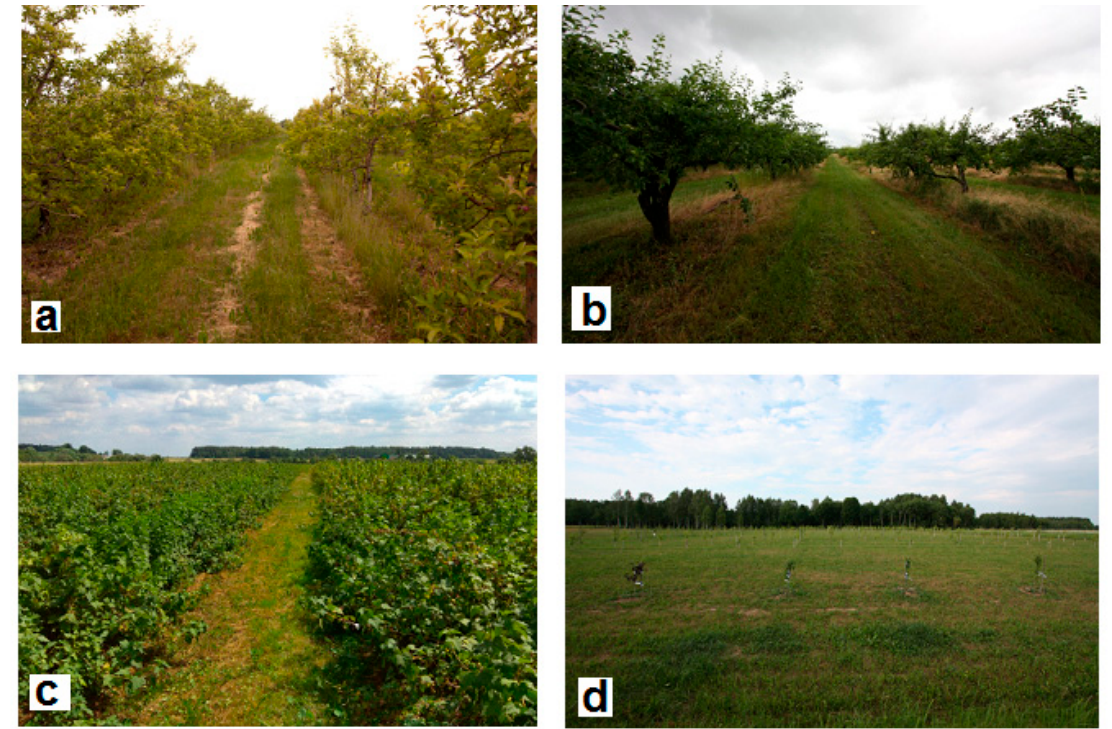
Figure A2 . Research sites with medium farming intensity: ( a ) apple fruit farm at site 1; ( b ) apple fruit farm at site 9; ( c ) currant plantation at site 14; and ( d ) young plum fruit farm at site 5.